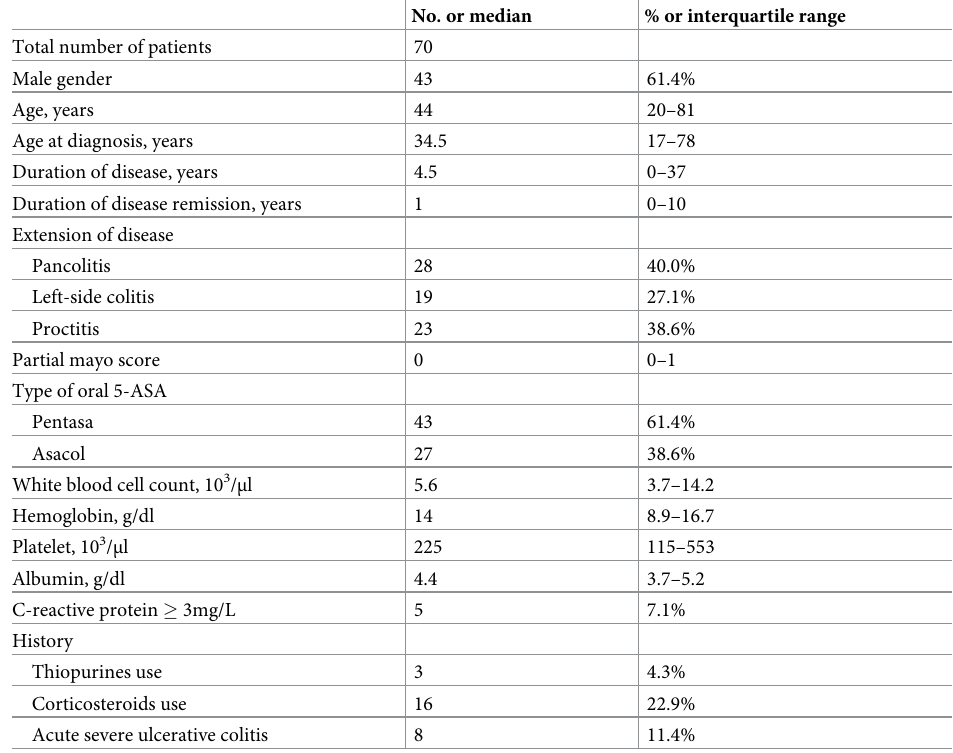
Table 1. Baseline characteristics of the 70 patients. 5-ASA: 5-aminosalicylic acids. No. or median % or interquartile